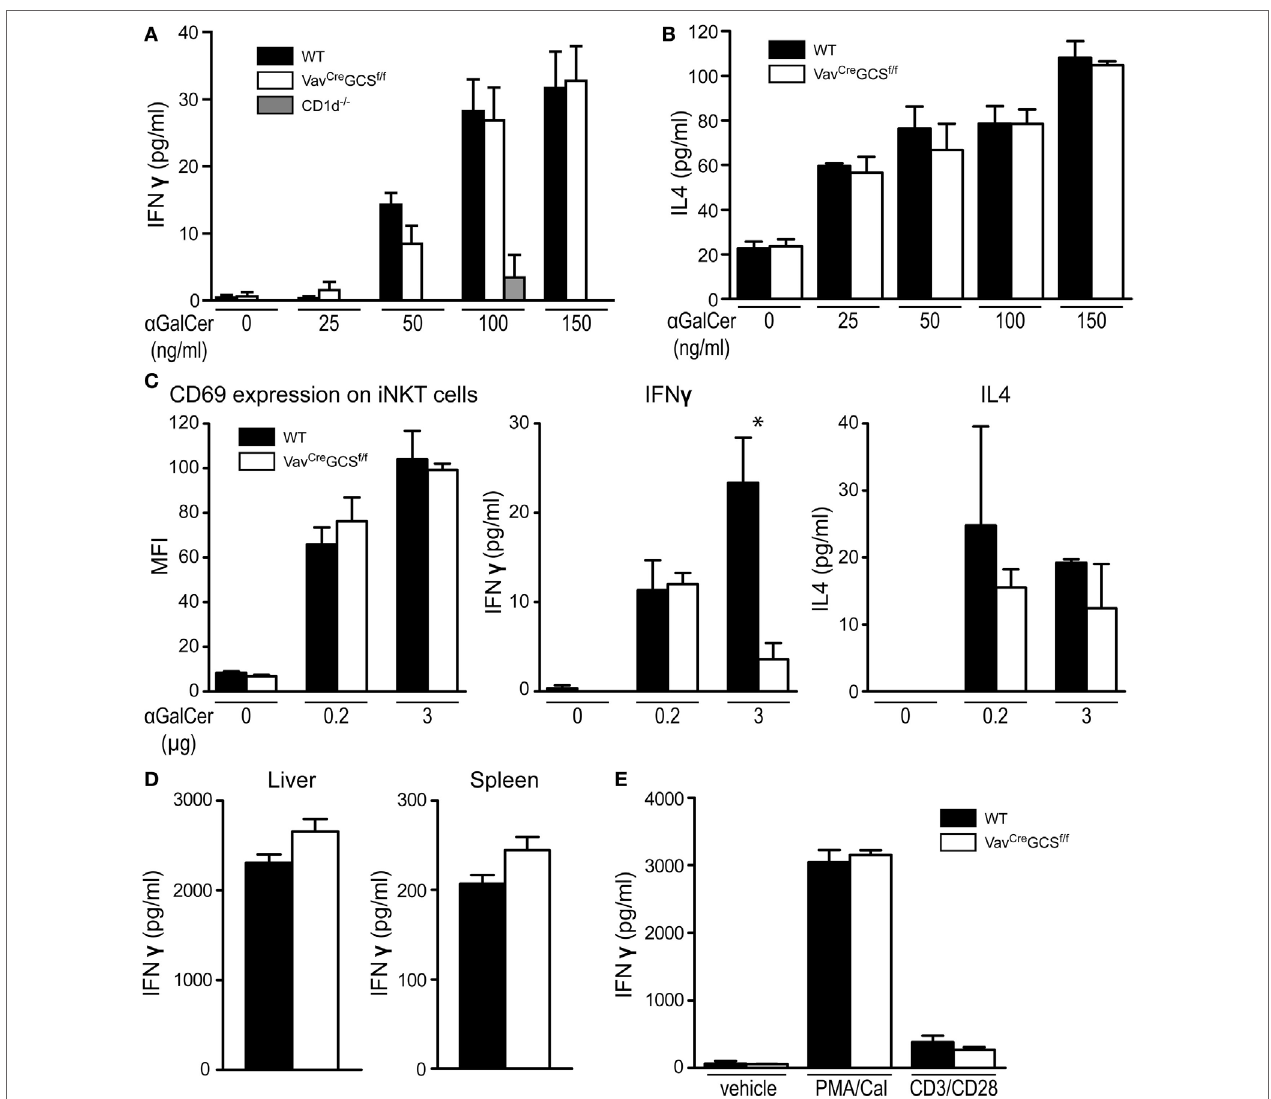
FigUre 7 | Antigen presentation and recognition in Vav Cre GCS f/f mice. (a,B) Double-positive (DP) thymocytes were tested for their antigen presentation capacity toward invariant natural killer T (iNKT) cells in vitro . To this end, iNKT-depleted wild-type (WT), Vav Cre GCS f/f , and CD1d –/– DP thymocytes were exposed to increasing concentrations of α GalCer and co-incubated with responder WT iNKT cells enriched from livers of TCRV α 14-J α 281 transgenic mice. The activation measured as secretion of IFN γ (a) and IL4 (B) did not differ between WT and Vav Cre GCS f/f DP thymocytes. CD1d –/– DP thymocytes served as negative controls, and the corresponding bars cannot be discriminated from the zero line in all but one concentration. Shown are means ± SEM, N = 6–9 per group. (c) Activation of iNKT cells was tested in vivo . WT and Vav Cre GCS f/f mice were i.p. injected with either 0.2 or 3 µg α GalCer. Eight hours later, splenic iNKT cells were analyzed for surface CD69 expression by flow cytometry by gating on CD19 − /PBS57-CD1d + /CD44 + lymphocytes. Expression of CD69 did not differ between WT and Vav Cre GCS f/f DP thymocytes. In parallel, serum was analyzed for IFN γ and IL4 levels. In Vav Cre GCS f/f mice injected with 3 µg α GalCer, IFN γ levels were significantly lower than in the WT controls. All other measurements did not show a statistically significant difference. Shown are means ± SEM, N = 3 per group. (D) Activation of iNKT cells was tested in vitro . iNKT cells from livers and spleens of WT and Vav Cre GCS f/f mice were exposed to α GalCer-loaded WT DP thymocytes. The activation measured as IFN γ secretion did not differ between WT and Vav Cre GCS f/f iNKT cells. Shown are means ± SEM, n = 3–6 per group. (e) Splenic conventional T cells were tested for their T cell receptor (TCR)-independent and TCR-dependent activation in vitro . WT and Vav Cre GCS f/f splenic T cells were activated by PMA/calcium ionophore A23187 or by plate-bound anti-CD3/anti-CD28 antibodies. Vehicle (media)-treated cells served as controls. No statistically significant differences could be found in the IFN γ secretion between WT and Vav Cre GCS f/f T cells. Shown are means ± SEM, n = 6 per